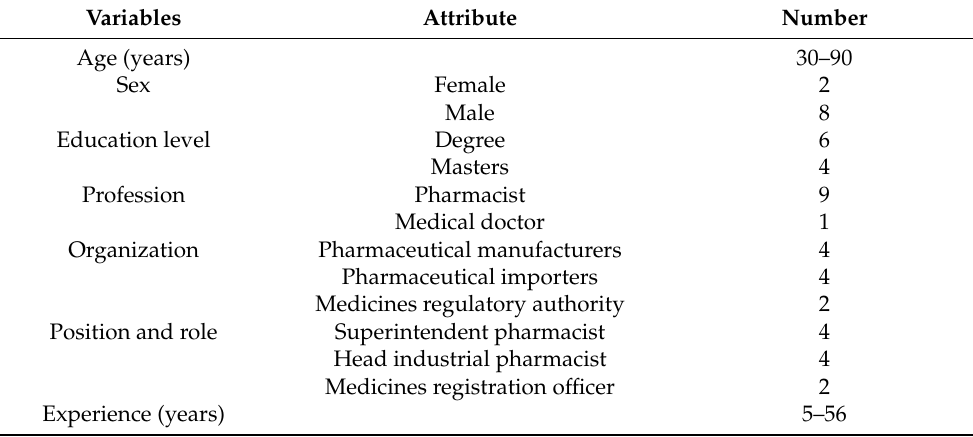
Table 1. Socio-demographic characteristics of study participants.